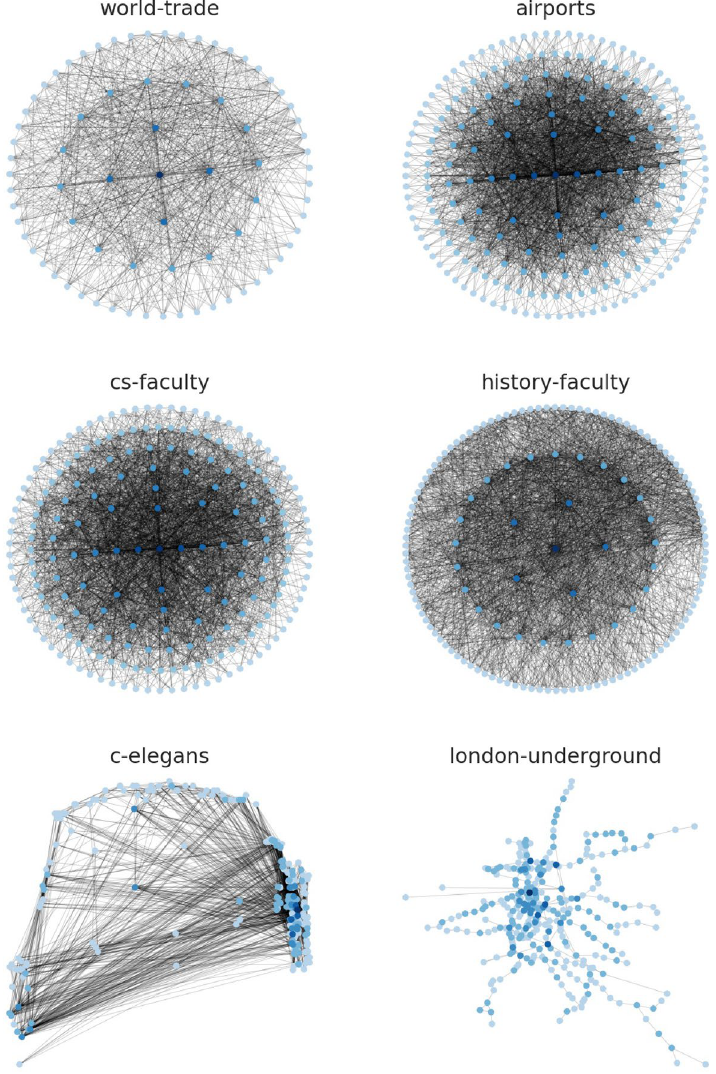
Figure 7. IGAM model fitted on small datasets (world-trade, airports, cs-faculty, histor-faculty, c-elegans, London-underground). The darker colors refer to nodes with higher prestige and the lighter colors refer to nodes with lower prestige. Source code to reproduce the Figure can be found in Ref. 33